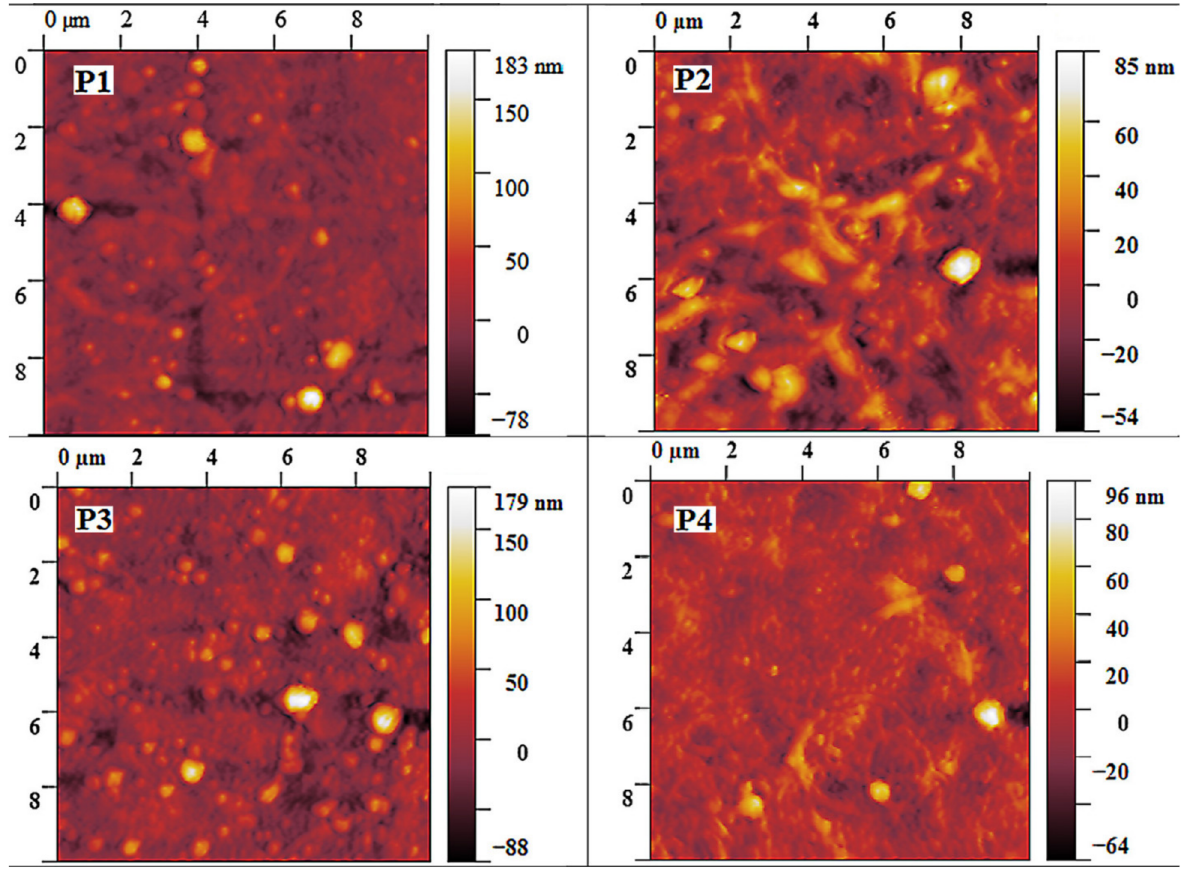
Figure 6. Topographic images of organic films ( P1 )—P3HT:C60 (1:1), ( P2 )—P3HT:C60 (2:1), ( P3 )—P3HT:C60 (1:2) and ( P4 )—P3HT/C60 obtained using MAPLE on AZO substrate. Reprinted with permission from [152]. Copyright 2017